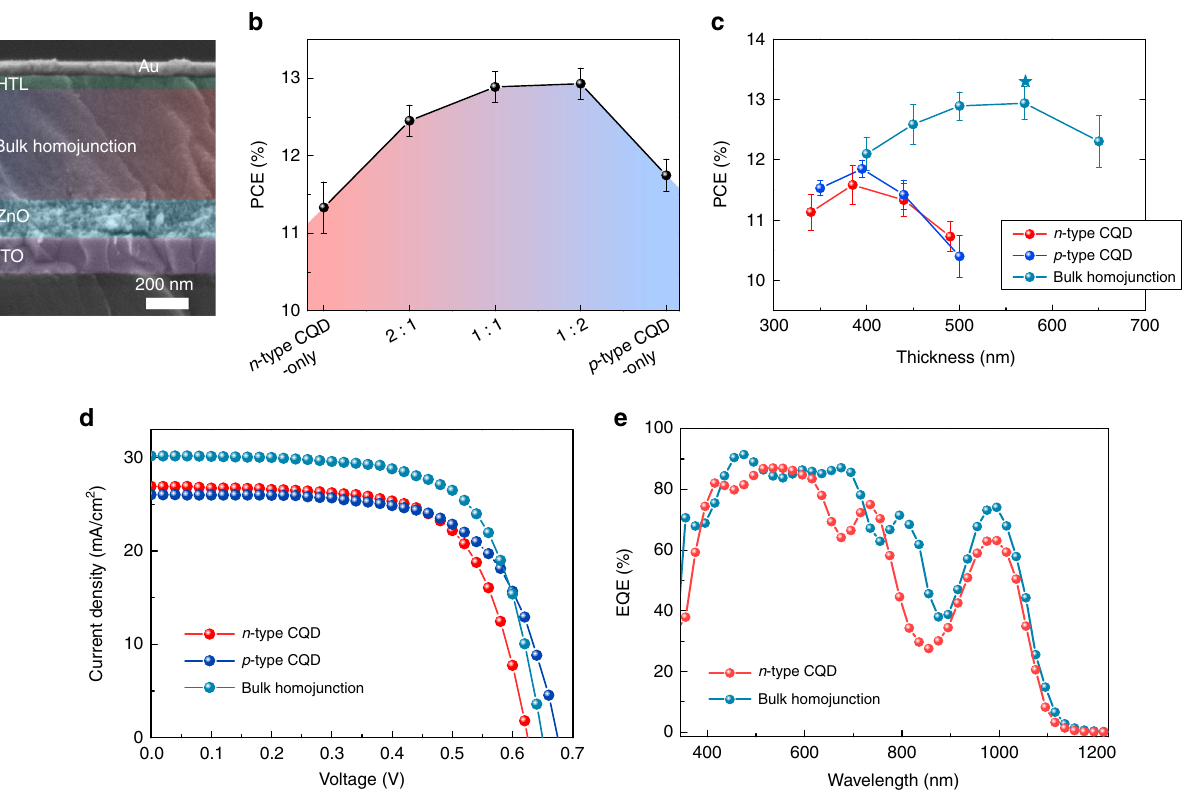
Fig. 5 Solar cell performance in devices employing CQD bulk homojunction fi lms. a Cross-sectional scanning electron microcopy image of CQD bulk homojunction device. b PCE of bulk homojunction devices with different mass ratios of p -type and n -type CQDs. The thickness of the active layer for the n - type CQD devices, p -type CQD devices, and bulk homojunction devices are ~390, 400, and 580 nm, respectively. c Thickness-dependent PCE for bulk homojunction devices and n -type CQD devices (control). Bulk homojunction devices enable the use of much thicker optimized CQD fi lms compared with the case of n -type CQD devices. d Current – voltage characteristics under AM1.5 illumination for n -type CQD device, p -type CQD device, and CQD bulk homojunction device at optimum fi lm thickness. e External quantum ef fi ciency of n -type CQD device and bulk homojunction device at optimum fi lm thickness. The average (symbols) and standard deviation (error bars) are calculated from a sample of six to twelve